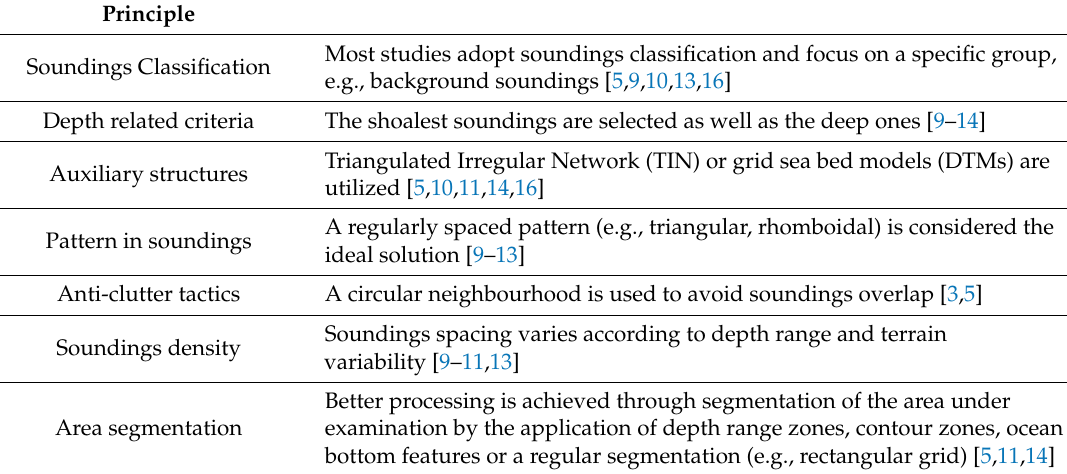
Table 1. Common principles on soundings